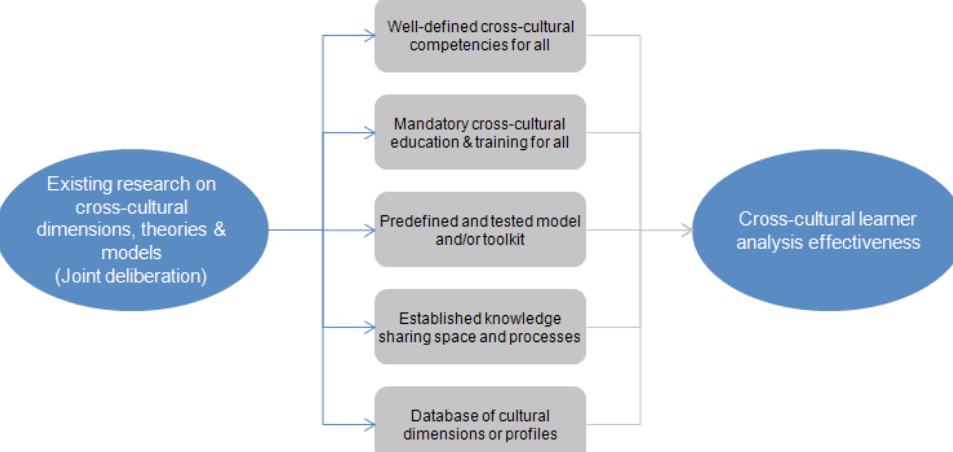
Figure 2. Cross-cultural learner analysis